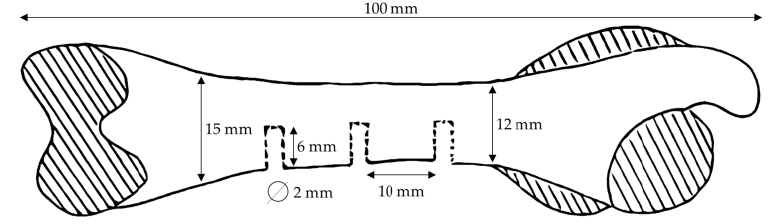
Figure 1. Scheme of implantation site locations on the rabbit